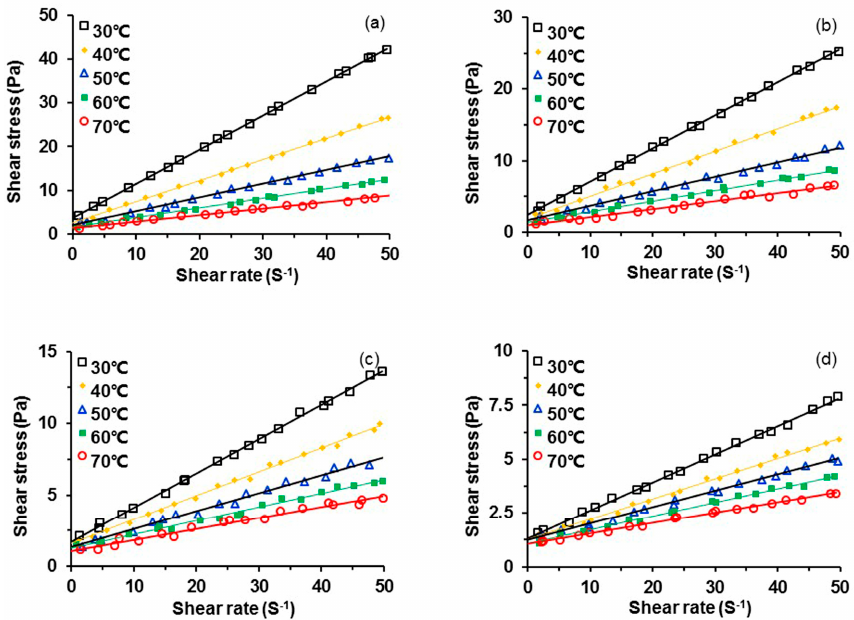
Figure 5 . Cont . Figure 5.